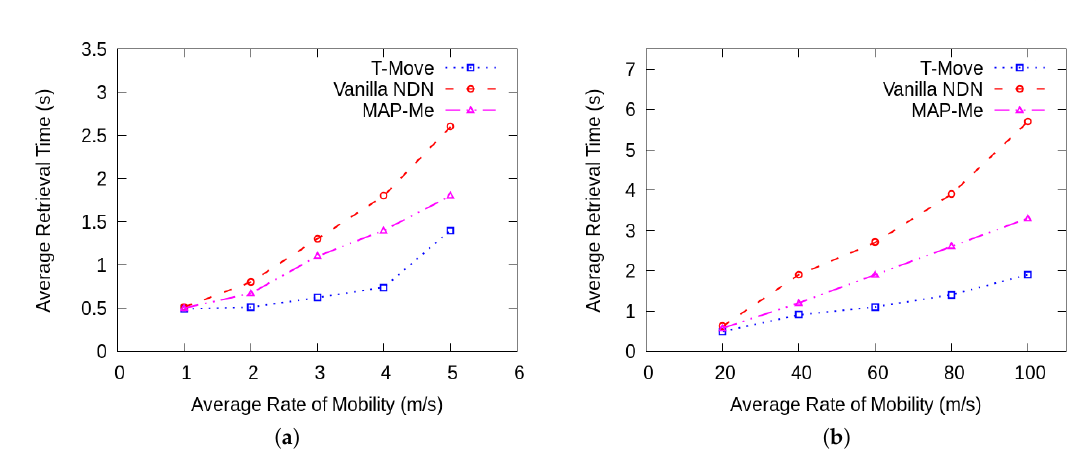
Figure 6. ( a ) Effect of Mobility Rate on Content Retrieval Time (Topology 1); ( b ) Effect of Mobility Rate on Content Retrieval Time (Topology 2).